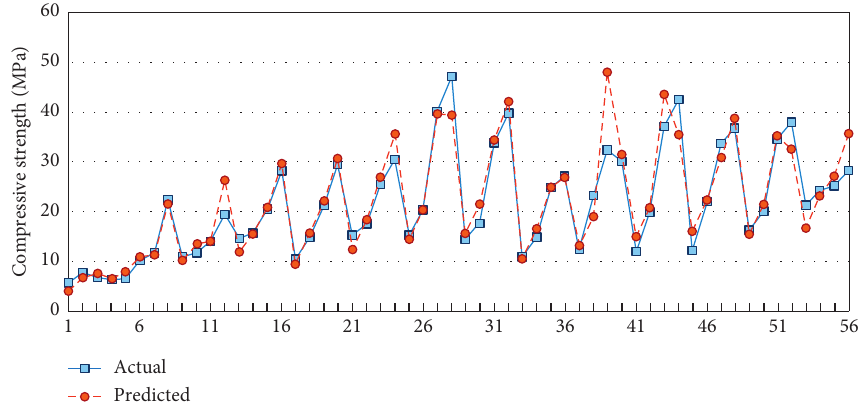
Figure 7: Actual vs. predicted values of the geopolymer’s cylindrical compressive strength.